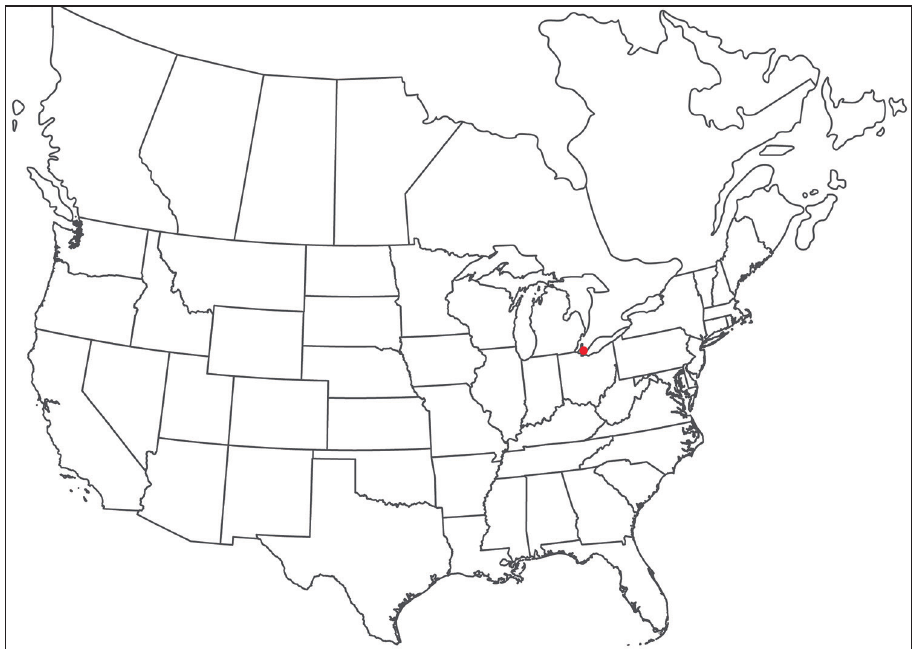
Figure 27. Torrenticola bittikoferae